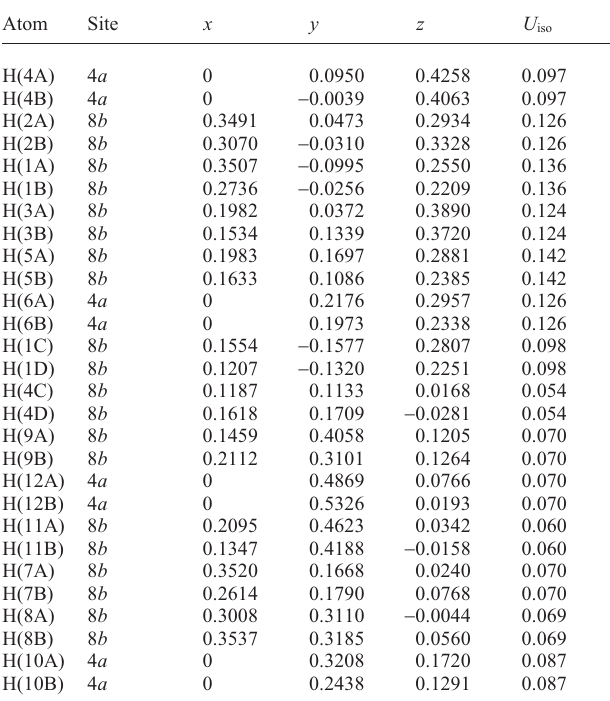
Table 2. Atomic coordinates and displacement parameters (in Å 2 )